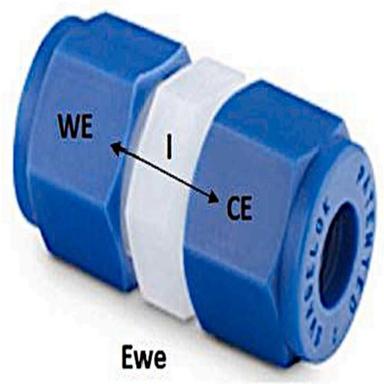
Swagelok® two-electrode cell.